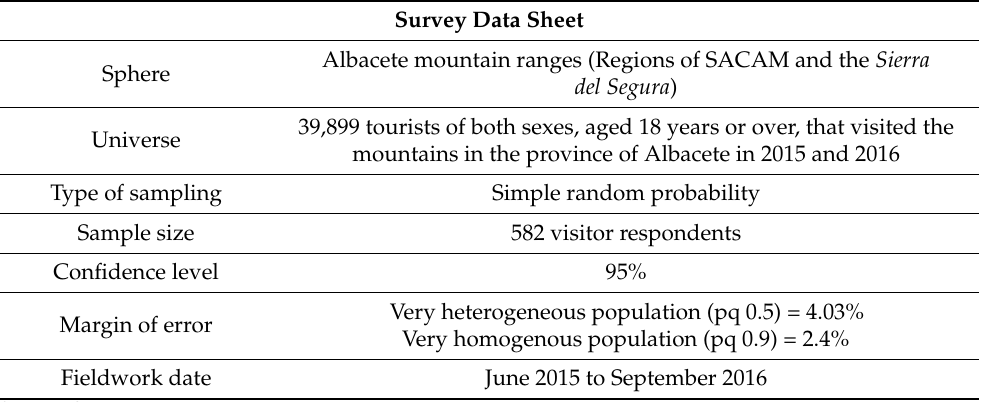
Table 1. Technical data sheet for the survey on visitors to the Albacete